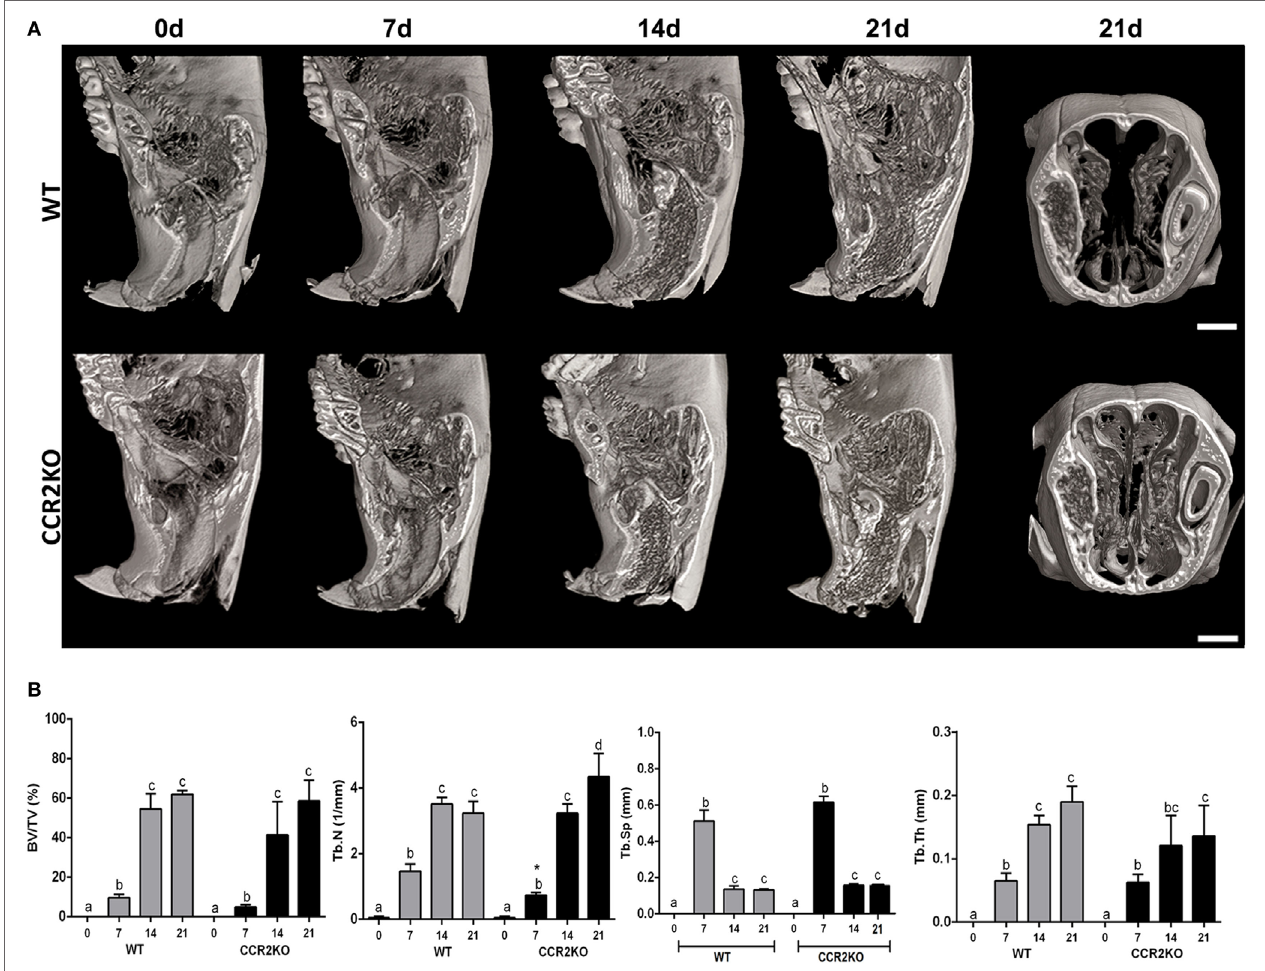
FigUre 2 | Micro-computed tomography ( μ CT) analysis along intramembranous bone healing in wild-type (WT) vs CCR2KO mice. Maxillae containing dental sockets post-extraction from WT and CCR2KO mice were scanned with the μ CT System (Skyscan 1174; Skyscan, Kontich, Belgium). (a) Three-dimensional images obtained by CT-Vox software reveal the socket morphology at 0 h, 7, 14, and 21 days post tooth extraction. (B) Morphological parameters such as bone volume fraction (BV/TV, %), trabecular number (Tb.N, 1/mm), trabecular separation (Tb.Sp, mm), and trabecular thickness (Tb.Th, mm) were quantified at 7, 14, and 21 days post tooth extraction. Results are presented as mean and SD to different parameters. Different letters indicate significant differences in each time point ( p < 0.05); symbol * indicate significant differences between WT vs CCR2KO at the same time